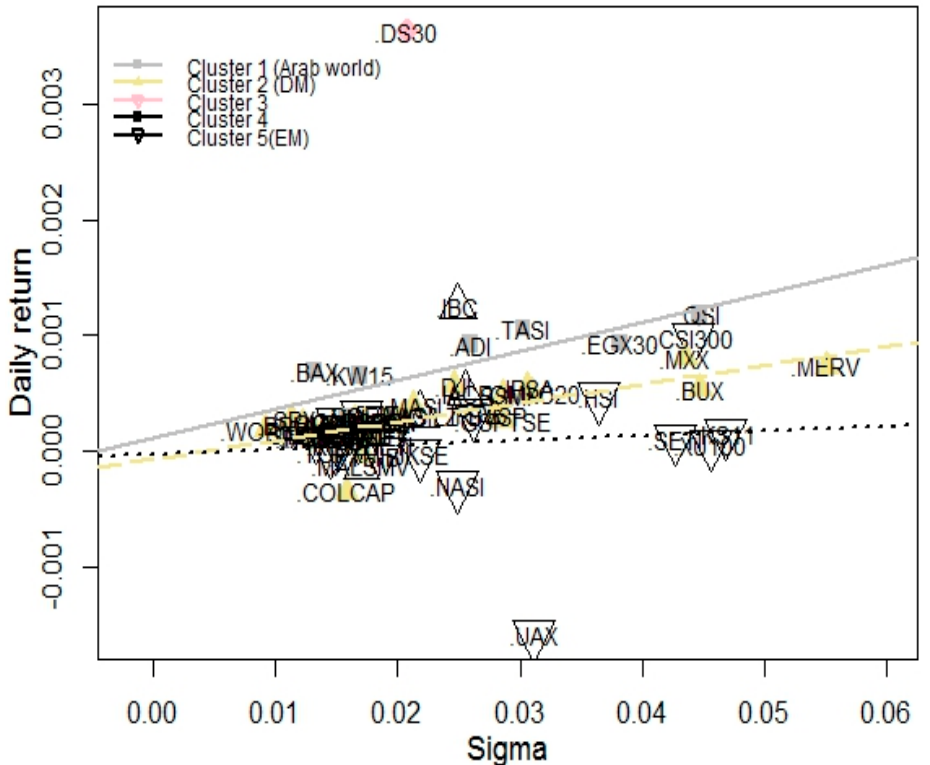
Figure 10. Three Gaussian-kernel based normalized modularity clusters, edges with weights stronger than 0.5.